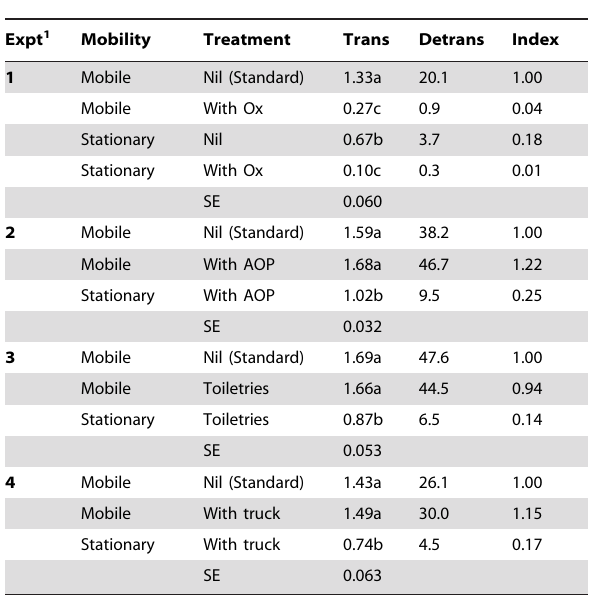
Table 4. Catches of G. m. morsitans from mobile and stationary men in various experiments.